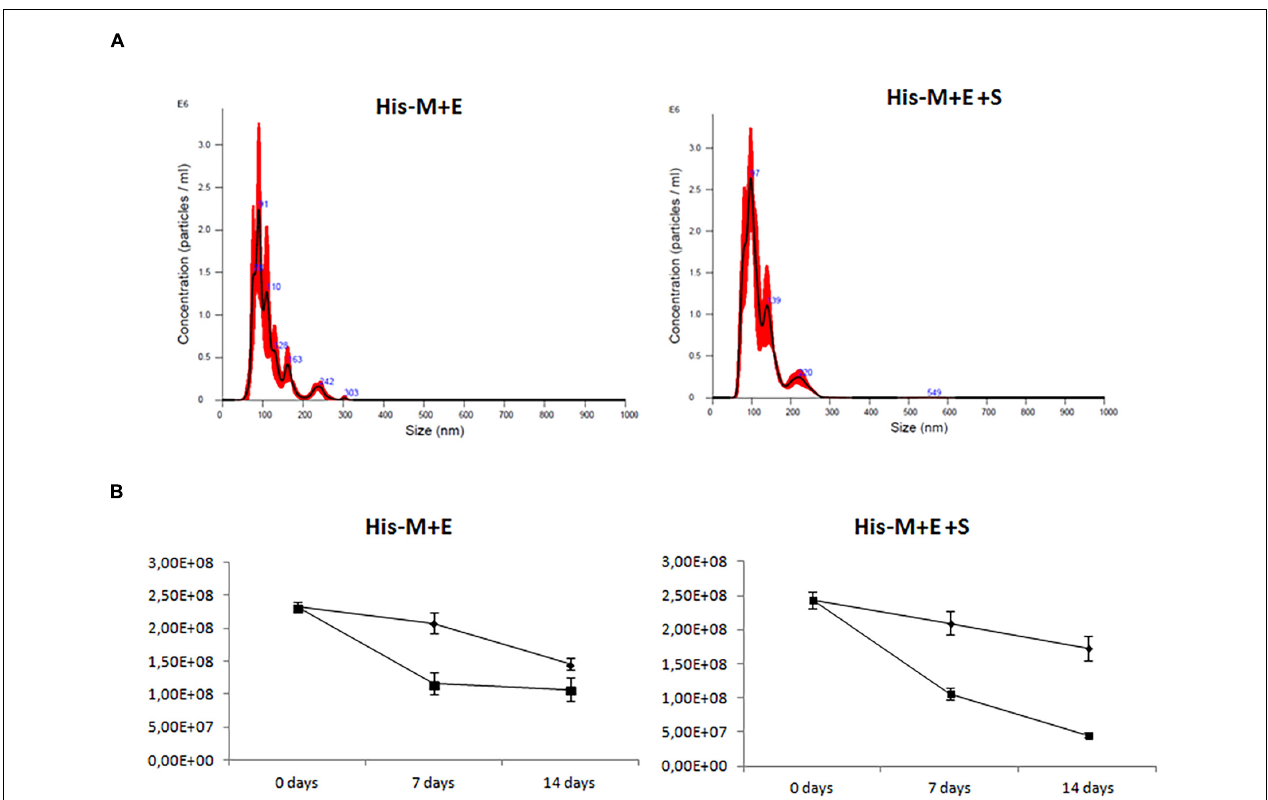
FIGURE 5 | Size distribution and quantification of His-tagged SARS-CoV-2 VLPs. Nanoparticle tracking analysis (Steppert et al., 2017). (A) Representative histograms showing the average size distribution of measured particles. Numbers in blue indicate particular peaks’ size, whereas the red surface corresponds to the standard deviation value. (B) Concentration (per 1 ml) of particles directly after purification, after 7 and 14 days’ storage in the fridge (4 ◦ C: diamonds) and freezer ( − 20 ◦ C: squares). Numbers shown on the y-axis are crude results from samples diluted 10 × before measurement. SARS-CoV-2, severe acute respiratory syndrome coronavirus 2; VLP, virus-like